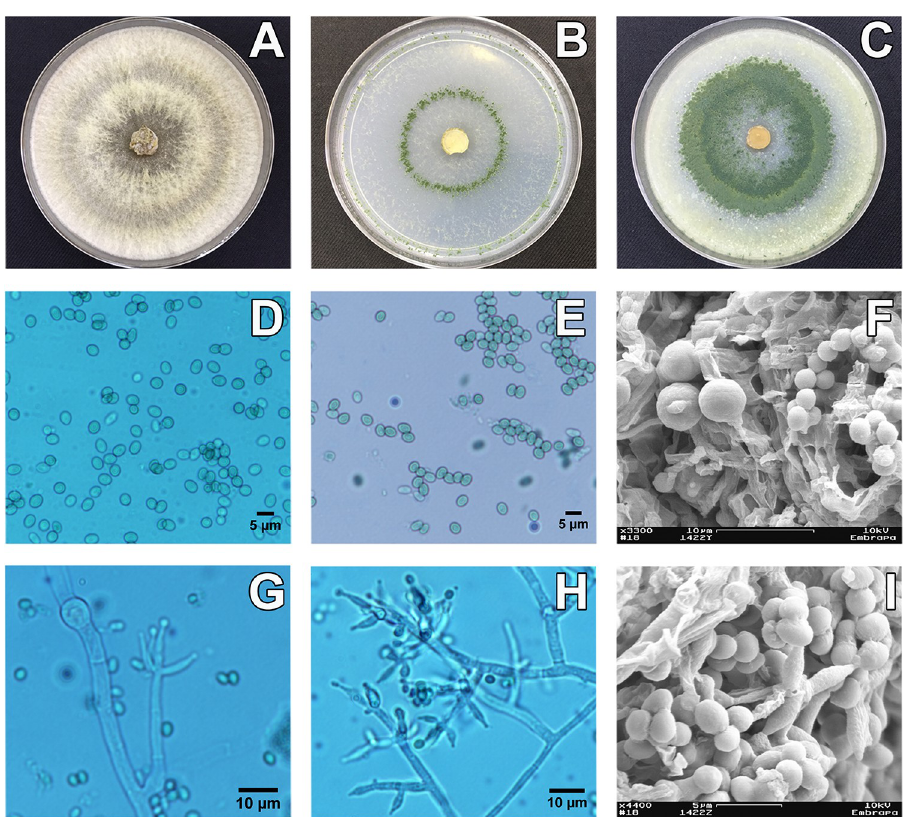
Fig 3. Culture characteristics and morphology of T. azevedoi sp. nov. strain CEN1422 (holotype). Panels A-I: Growth on three different media, PDA (A); SNA (B); CMD (C); and morphology of the conidia (D, E), phialides